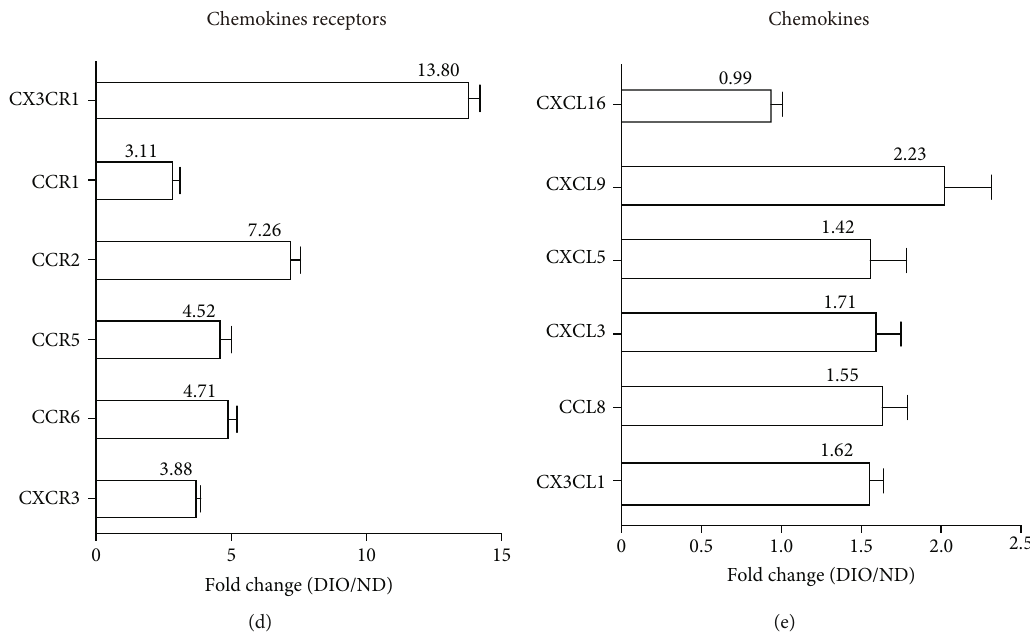
Figure 3: The expression of chemokines was positively correlated with DIO-induced liver metastasis of PDAC in mice. (a) Volcano plot of di ff erent gene expression in ND liver and DIO liver. Each point represented gene mRNA levels, fold change for ND and DIO. ð FC Þ ∣ ≦ 1 : 2 , P value ≦ 0.05). (b, c) KEGG and GO pathway analysis on signi fi cantly upregulated genes between ND and DIO tissue ( ∣ Log 2 ð FC Þ < ∣ 2 ∣ . (d, e) Expression analysis of chemokines receptors and chemokines in livers; the expression of samples. FDR < 0 : 01 , Log 2 chemokines receptors and chemokines in DIO was normalized by ND. The multiples of the expression of chemokines and chemokines receptors in DIO were marked on the